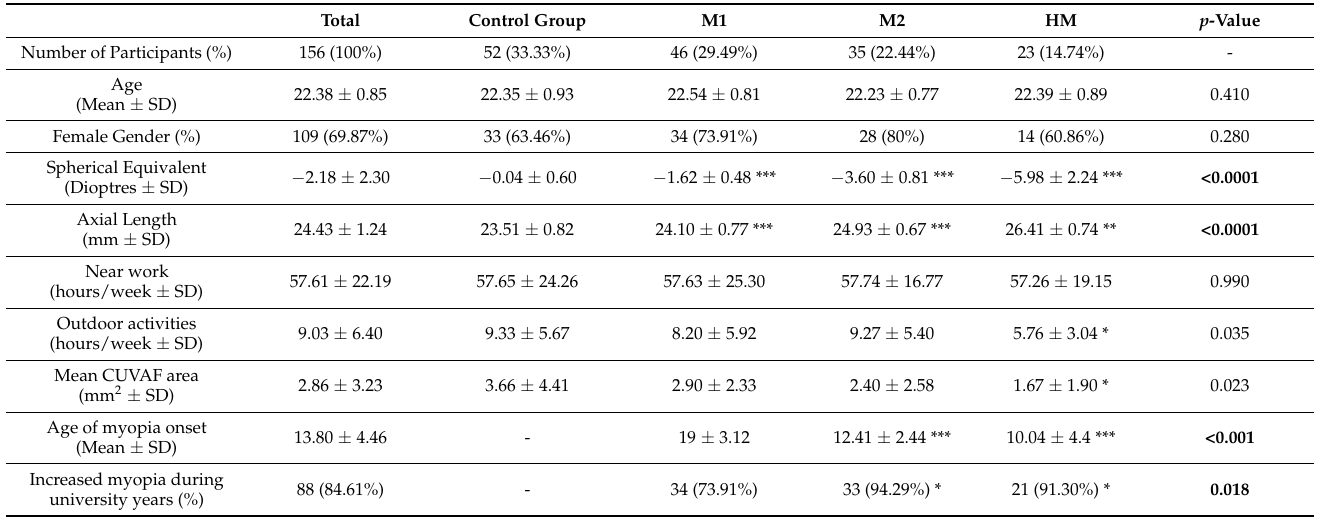
Table 1. Demographic and ophthalmological characteristics of the medical students.